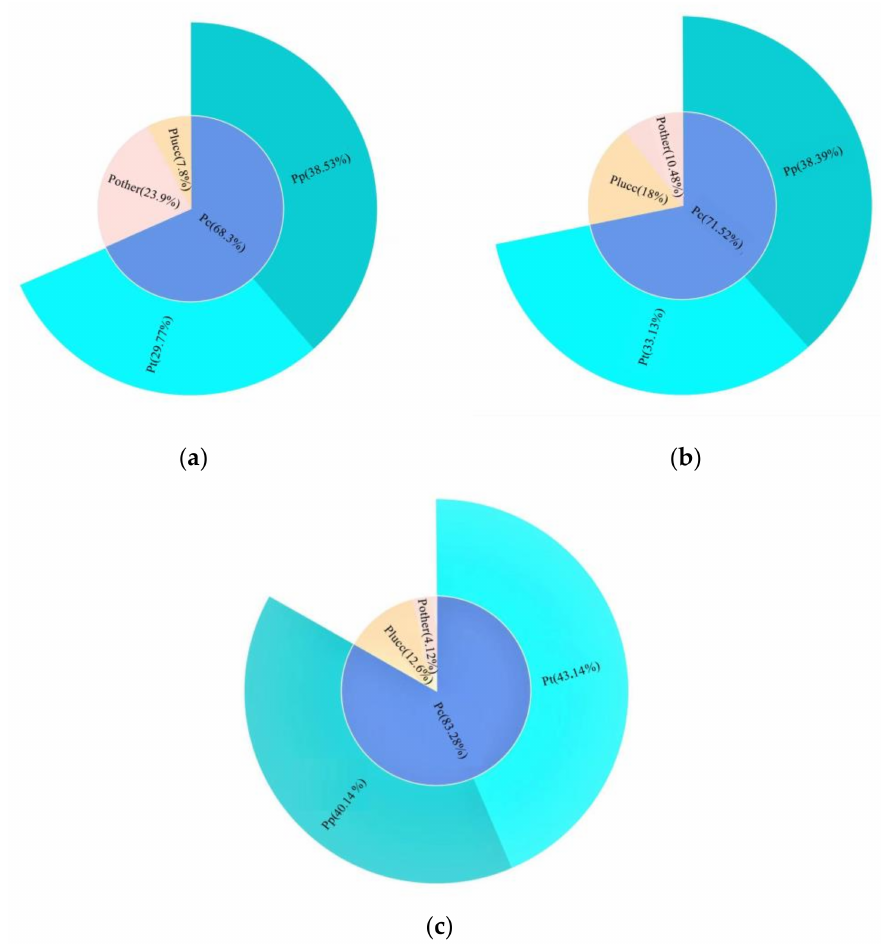
Figure 10. Contributions of land-use and -cover changes (Plucc), climate fluctuation (Pc), other human activities (Pother), temperature (Pt), and precipitation (Pp) to SWAT–PDSI changes in the Yihe River Basin from 1990 to 1999 ( a ), 2000 to 2009 ( b ), and 2010 to 2019 ( c